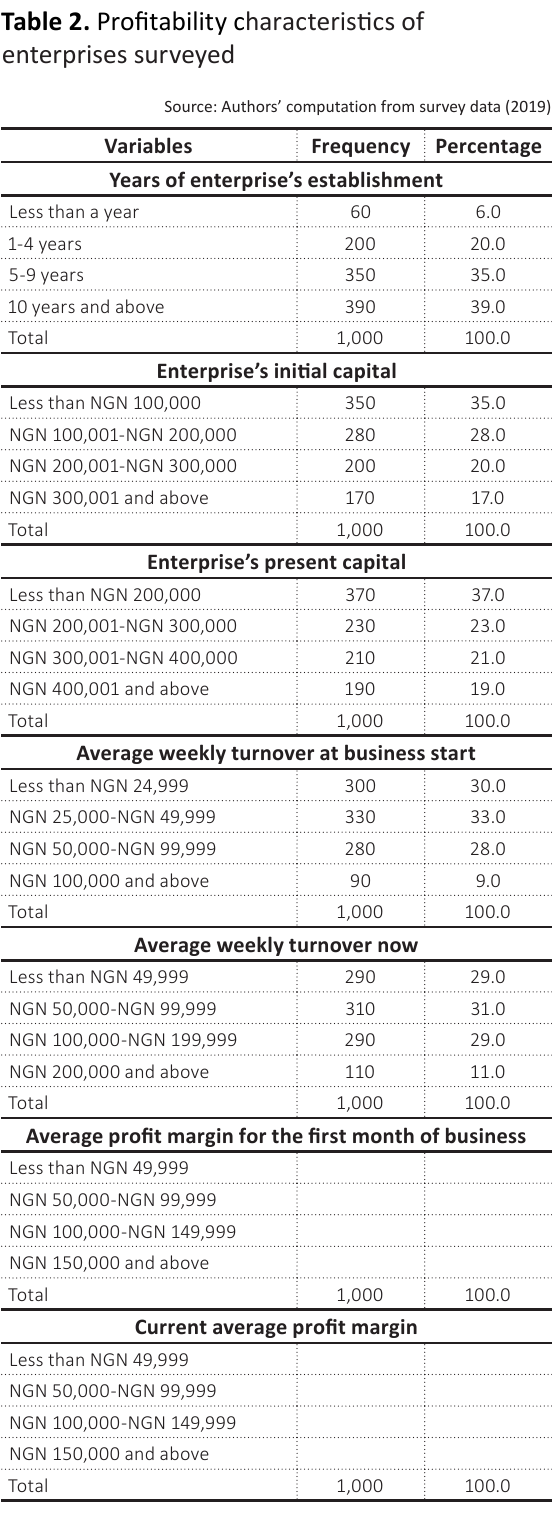
Table 3. Job creation in the enterprises surveyed